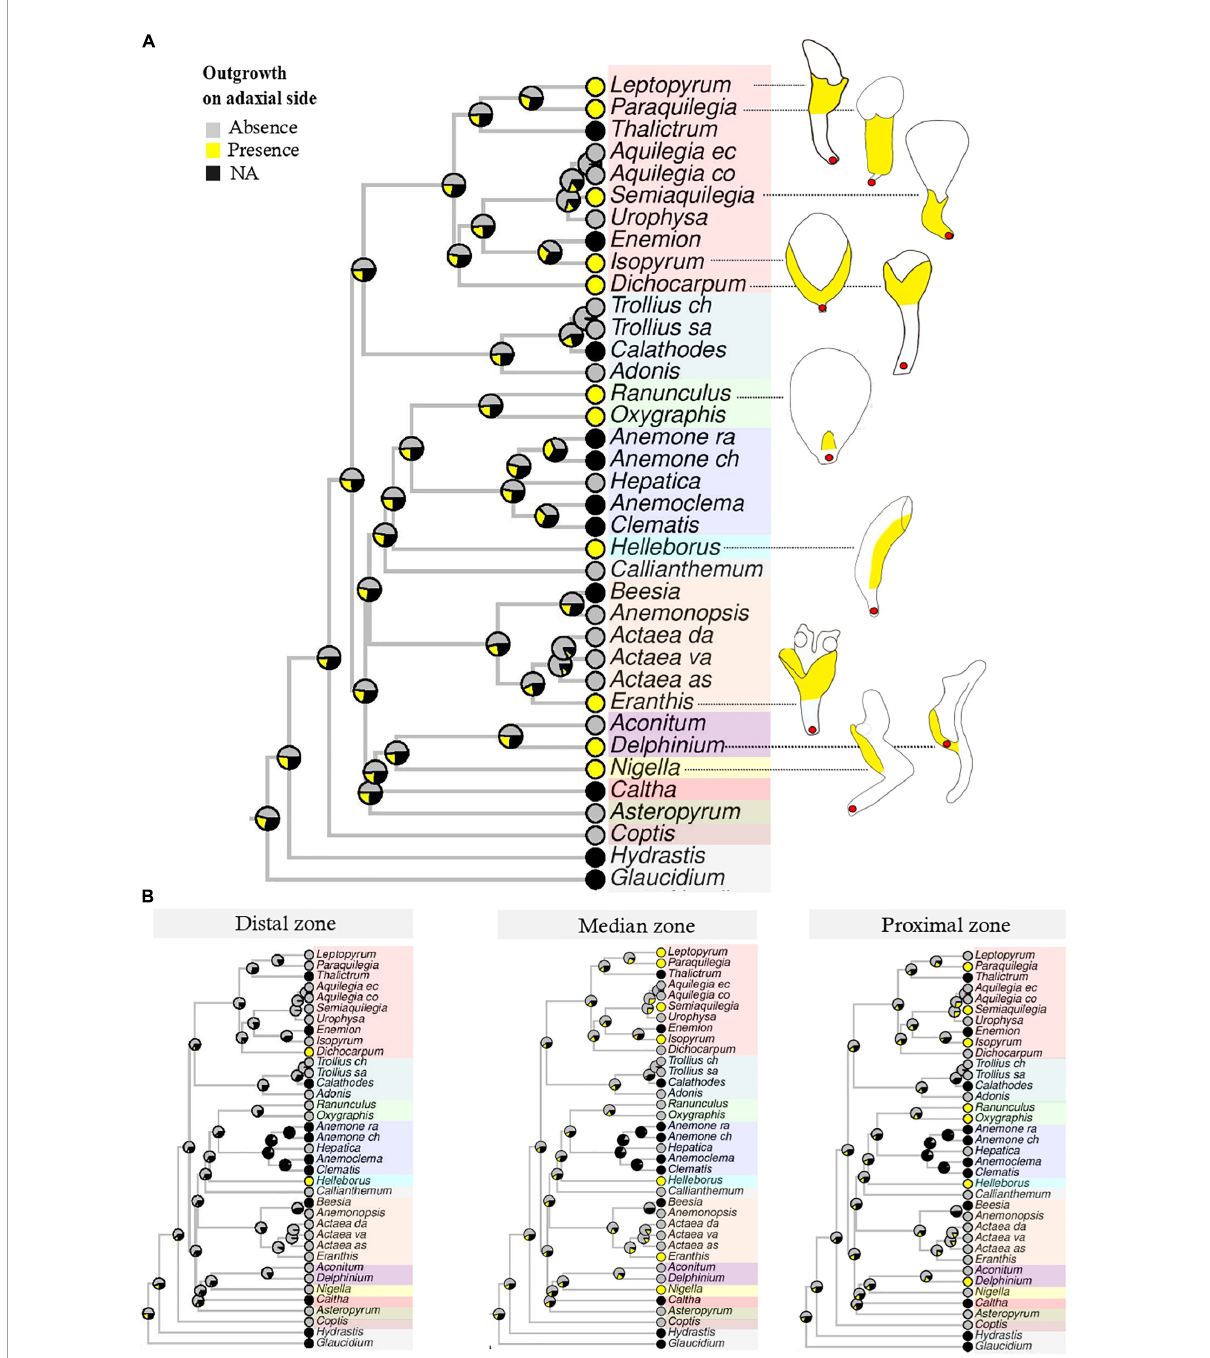
FIGURE3 Bayesian ancestral state reconstructions for the character “Outgrowth on adaxial side.” Character states include “Absence,” “Presence,” “NA” (non-applicable, i.e., petals absent). (A) The character is coded for the petal as a whole, notwithstanding the zonation. Outgrowths are given in yellow in the line drawing. (B) The same character is coded for each zone (proximal, median, distal) separately.